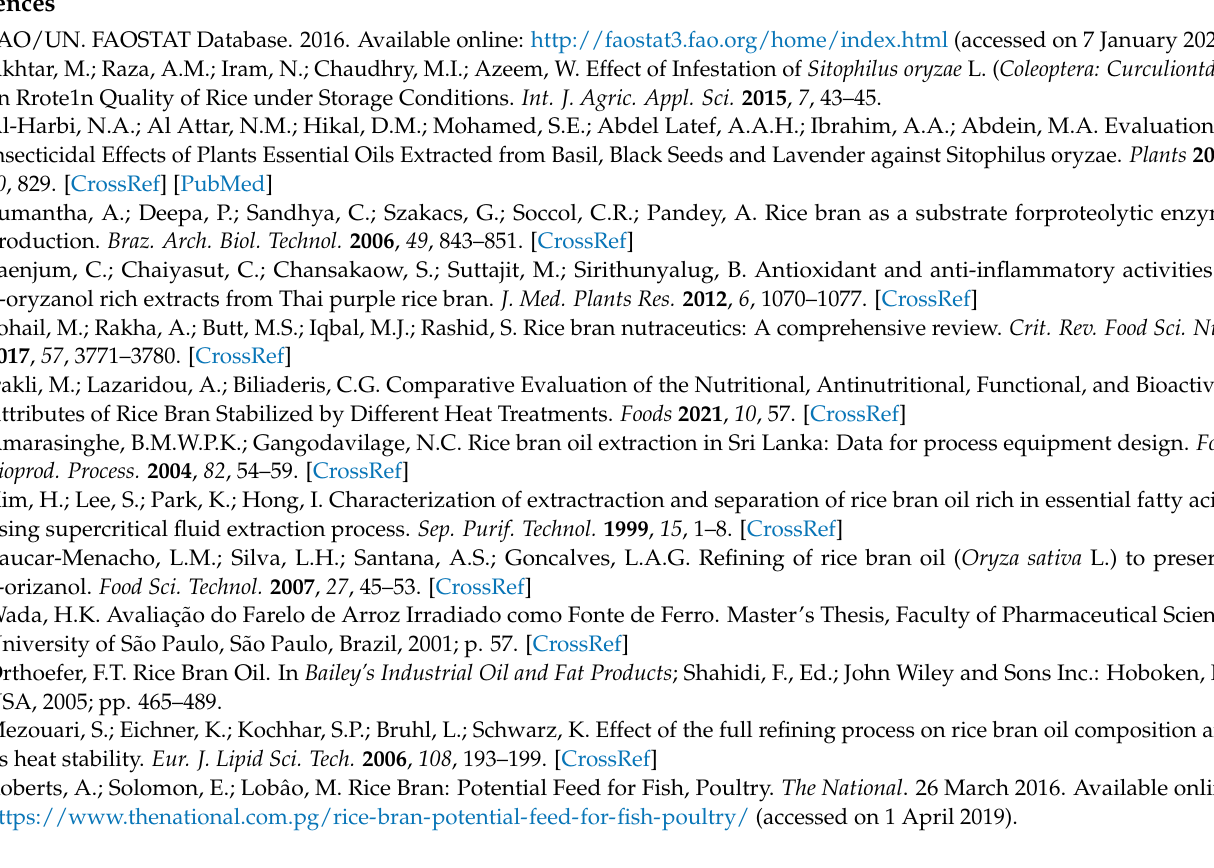
season. Table S2: Analysis of variance for chemical composition percentage of milled rice grains of the studied genotypes during the 2019 and 2020 growing season. Table S3: Analysis of variance for gross chemical composition (%) and minerals content (mg/100 g) of stabilized rice bran samples of the studied genotypes during the 2019 and 2020 growing season. Table S4: Analysis of variance for some physical, chemical properties, and fatty acids profile of rice bran oil from some rice genotypes (dry weight basis) of the studied genotypes during the 2019 and 2020 growing